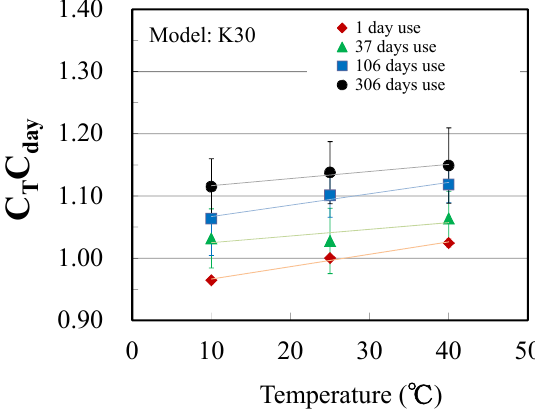
C in the case of K30 (n = T day